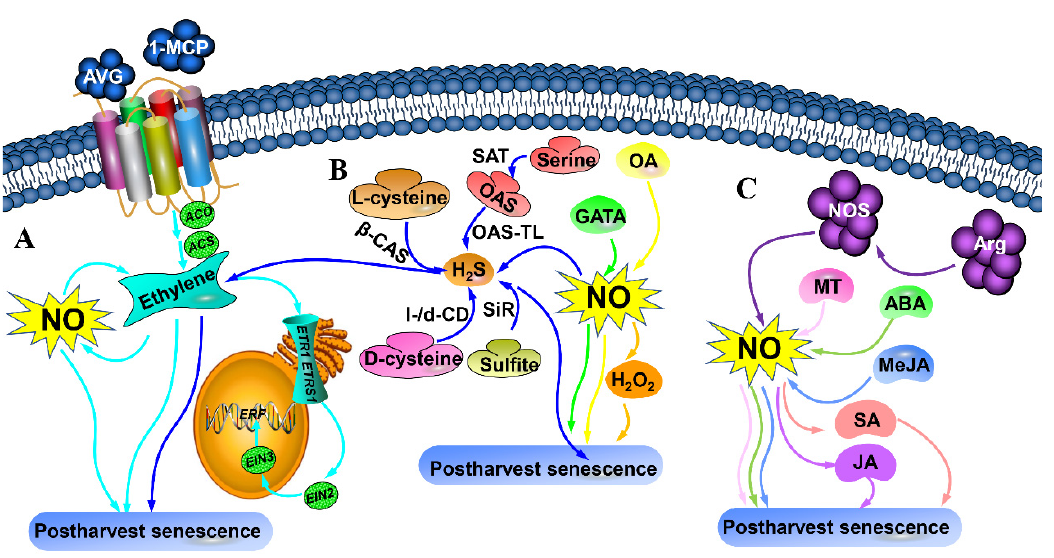
Figure 3. Schematic model of the interaction among H 2 , H 2 S, H 2 O 2 and other plant hormones in postharvest senescence. ( A ) NO interacts with ethylene, ( B ) NO interacts with H 2 S, H 2 O 2 , GATA or OA, ( C ) NO interacts with plant hormones. AVG, aminoethoxyvinylglycine; 1-MCP, 1-methylcyclopropene; Arg, arginine; OA, oxalic acid; NOS, nitric oxide synthase; ABA, abscisic acid; NO, Nitric oxide; H 2 S, hydrogen sulfide; H 2 O 2 , hydrogen peroxide; MT, Melatonin; MeJA, Methyl jasmonate; GABA, γ -aminobutyric acid; l-/d-CD, 1-/d-cysteine desulfhydrase; OAS-TL, O-acetylserine (thiol)lyase; SiR, sulfite reductase; β -CAS, β -cyanoalanine synthase; JA, jasmonic acid; SA, salicylic acid.